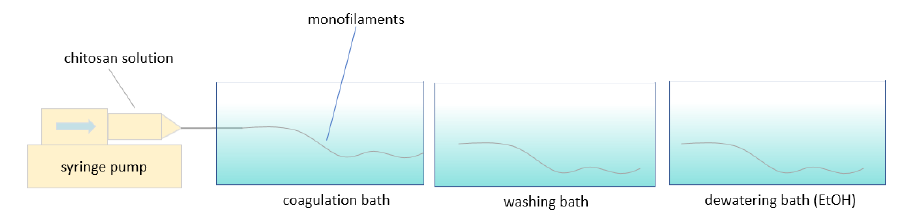
Figure 1. Schematic presentation of the wet spinning